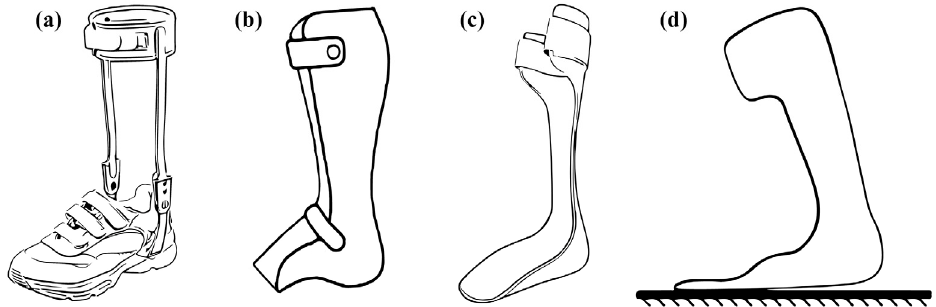
Figure 2. Solid AFOs: ( a ) metal AFO, ( b ) plastic AFO, ( c ) posterior-leaf-spring AFO, ( d ) Ground- reaction AFOs.